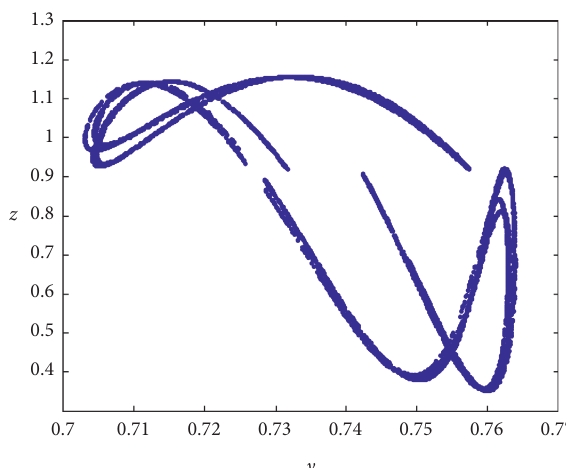
Figure 4: x – n sequence diagram which denotes that the system is periodic when α � 0.95.